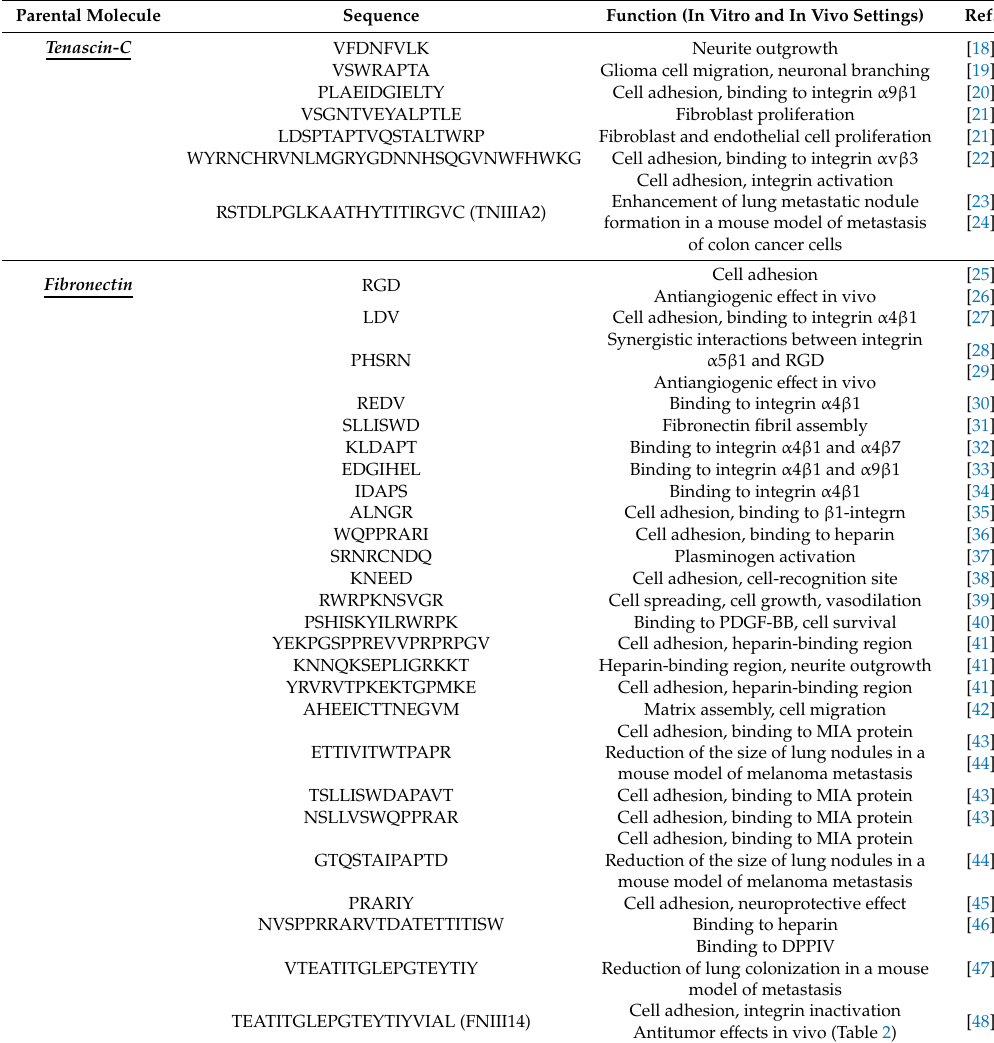
Table 1. Tenascin-C or fibronectin-derived bioactive sequences.